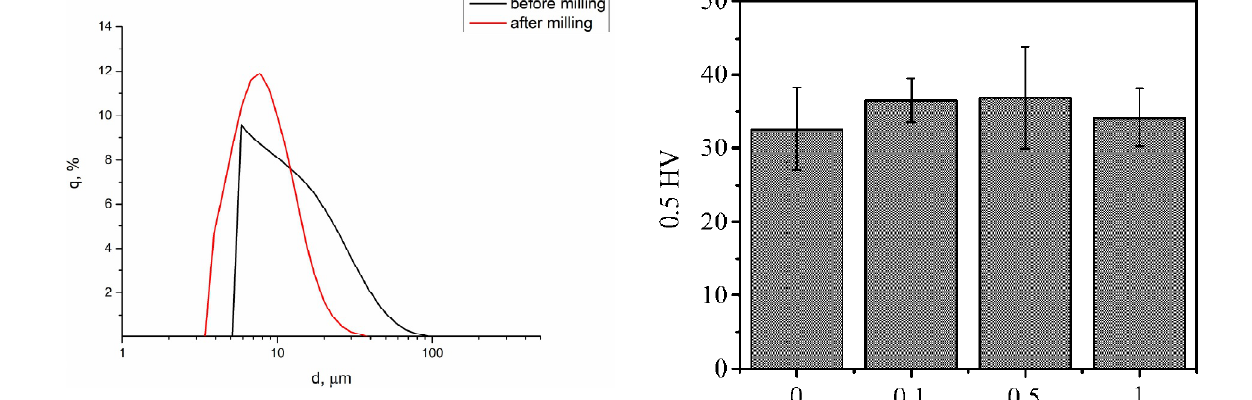
Fig. 5. Particle size distribution in copper powders before and after milling.